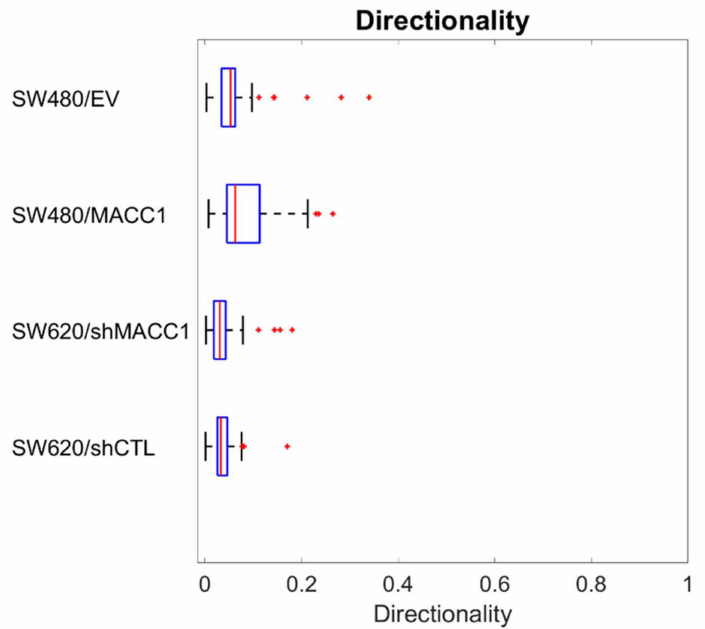
Figure A3. Directionality of single cells. Box plots show the median (red line), 25 and 75 per- centile (box), non-outlier range (whiskers), and outliers (red dots). Sample sizes: n SW480/EV = 66; n SW480/MACC1 = 98; n SW620/shMACC1 = 102; n SW620/shCTL =